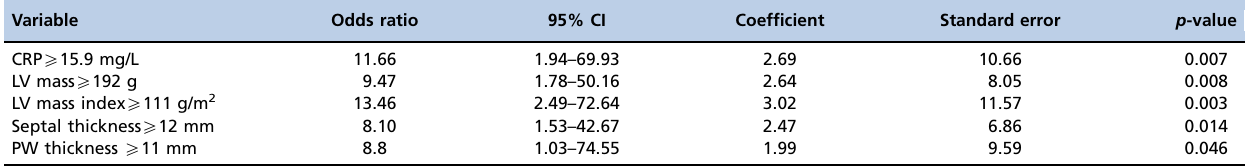
Table 2 - Predictors of rejection after 30 days on univariate regression analysis. Variable Odds ratio 95% CI